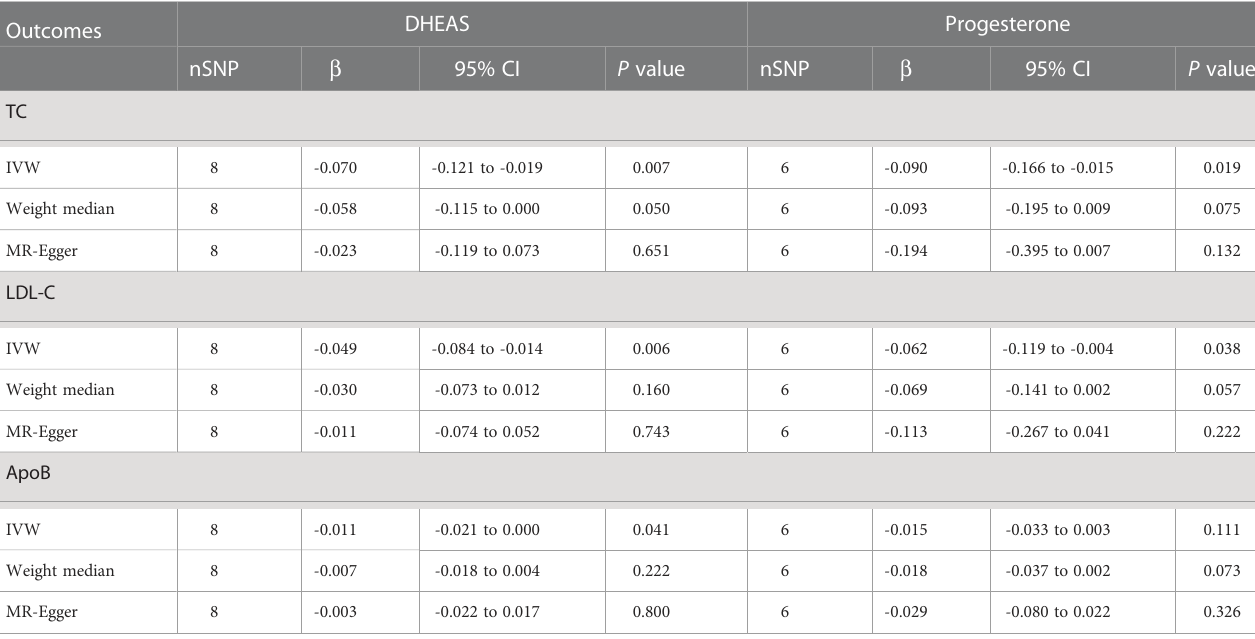
TABLE 1 MR estimates for the association between steroid hormones and lipid metabolism in males.